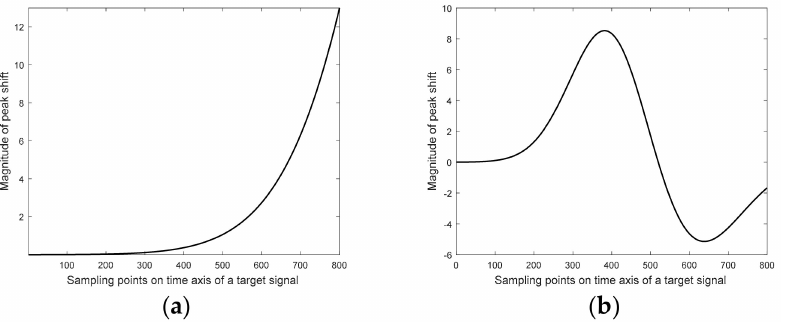
Figure 10. Two templates of warping functions: ( a ) smooth and nonlinear and ( b ) smooth and strongly